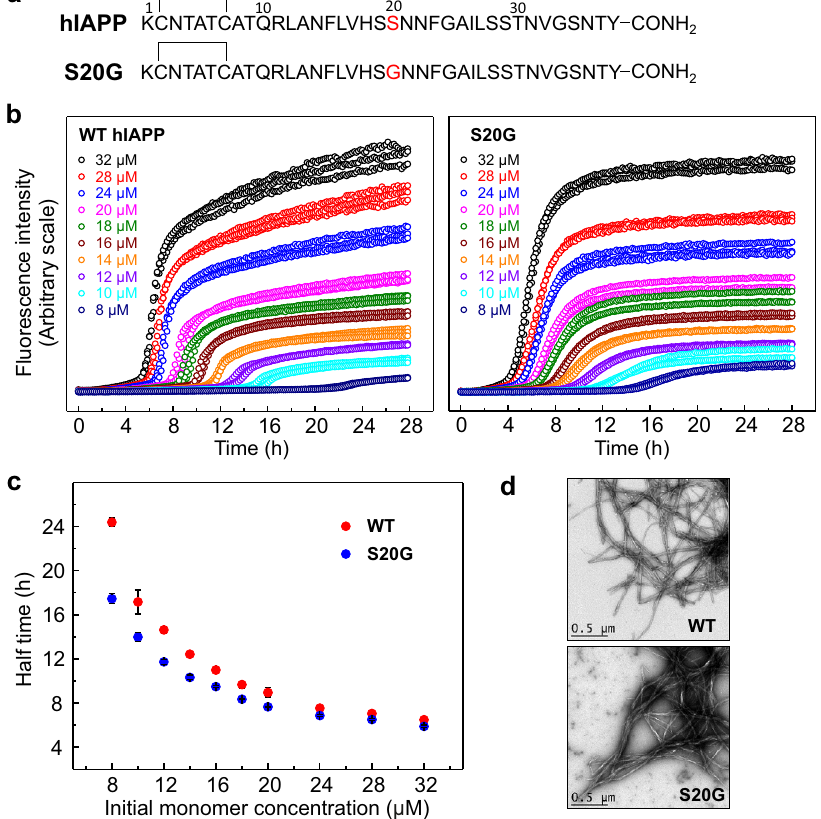
Fig. 1 Concentration-dependent aggregation of wt hIAPP and S20G. a Sequences of wt hIAPP and the variant S20G. Both peptides have a disul fi de bond between Cys-2 and Cys-7 and amidated C-termini. b Concentration-dependent aggregation kinetics of wt hIAPP and S20G. ThT fl uorescence intensity of wt hIAPP and S20G is plotted over time at initial monomer concentrations ranging from 8 μ M to 32 μ M. Each experiment was performed three times with three technical replicates each time using different batches of the peptides. Samples contained different concentrations of peptide, 25 mM sodium phosphate buffer, 50 μ M ThT and 2% (v/v) DMSO at pH 6.8 and were incubated at 30 °C quiescently. c Plots of half time (t 50 ) versus the initial monomer concentration. Results are mean ± SD of n = 3. d TEM images of wt hIAPP and S20G fi brils taken from wells containing 10 μ M peptide after the ThT fl uorescence had reached a plateau (42 h). The scale bar is 0.5 μ m. The TEM images are consistent in all three